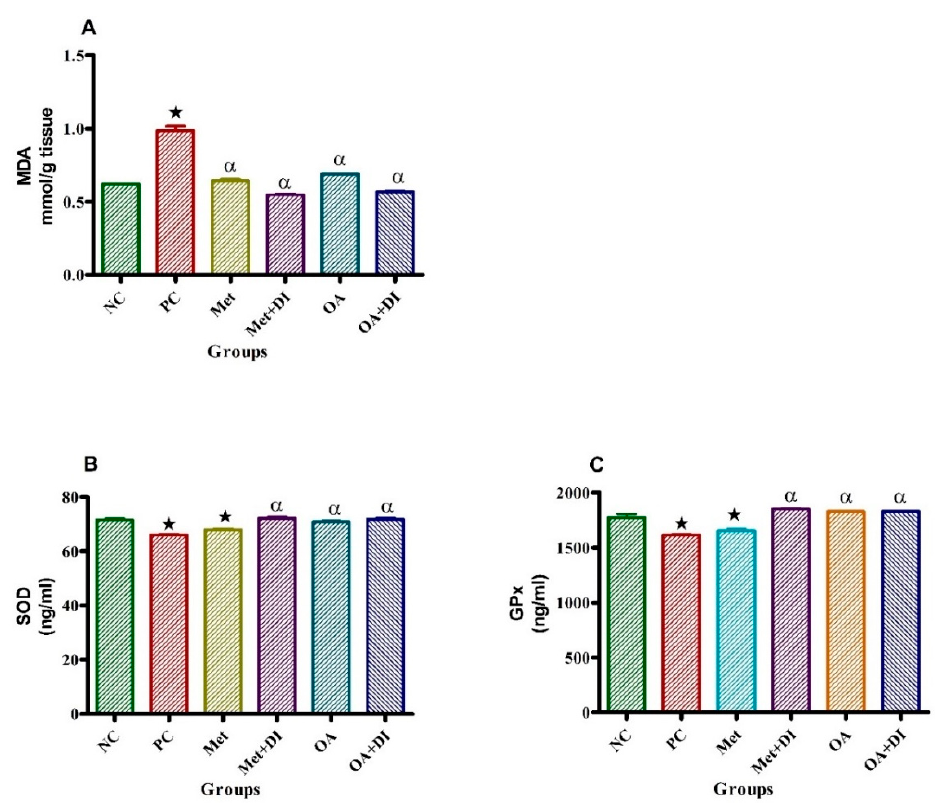
Figure 4. Effects of OA and Met ( n = 6, per group) on MDA, SOD and GPx of rats that changed from HFHC diet to normal diet. Values are presented as standard error of mean ± SEM. Non-pre-diabetes control (NC), pre-diabetes control (PC), metformin treated with dietary intervention (Met + DI) and oleanolic acid treated with dietary intervention (OA + DI). p < 0.05 denotes comparison with NC; α = p < 0.05 denotes comparison with